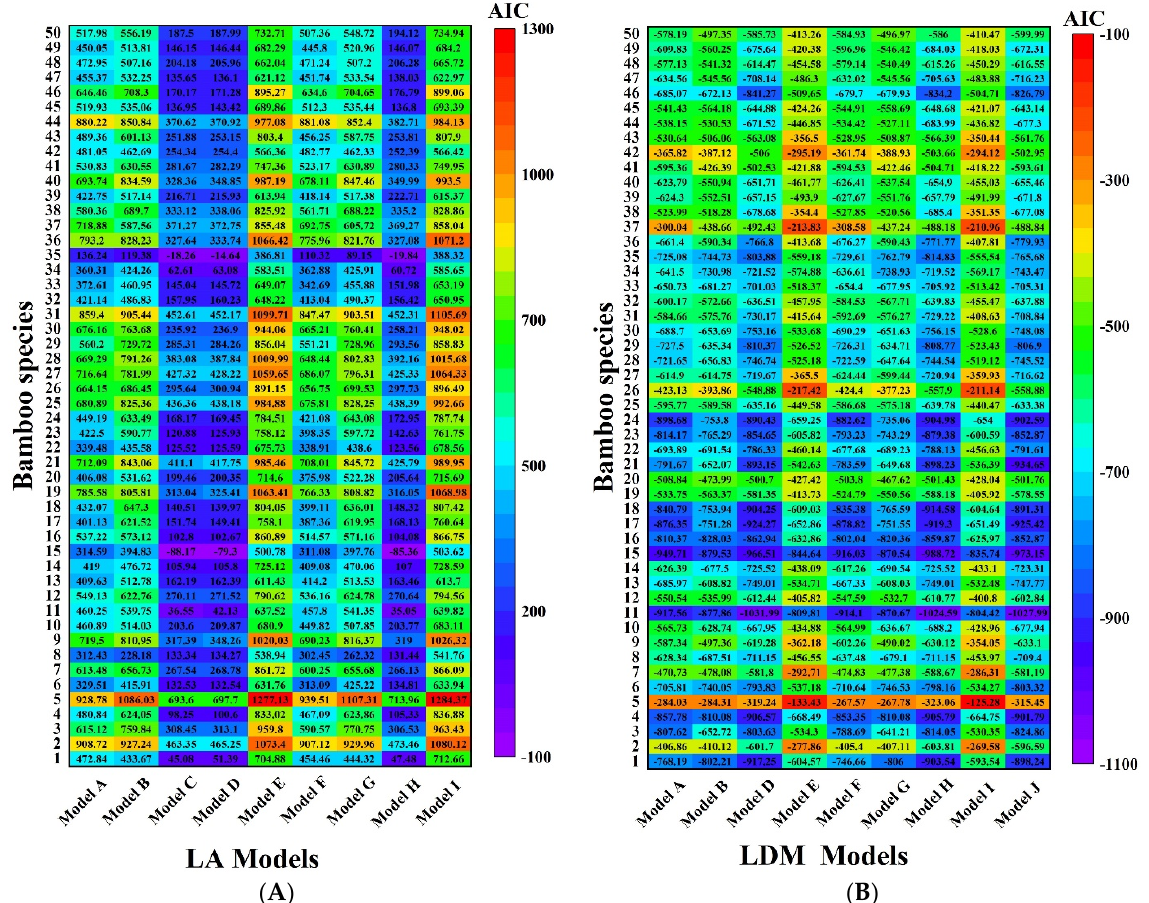
Figure 2. Comparison of AIC values calculated for different models for LA ( A ) and LDM ( B ) estimations of 50 bamboo species.